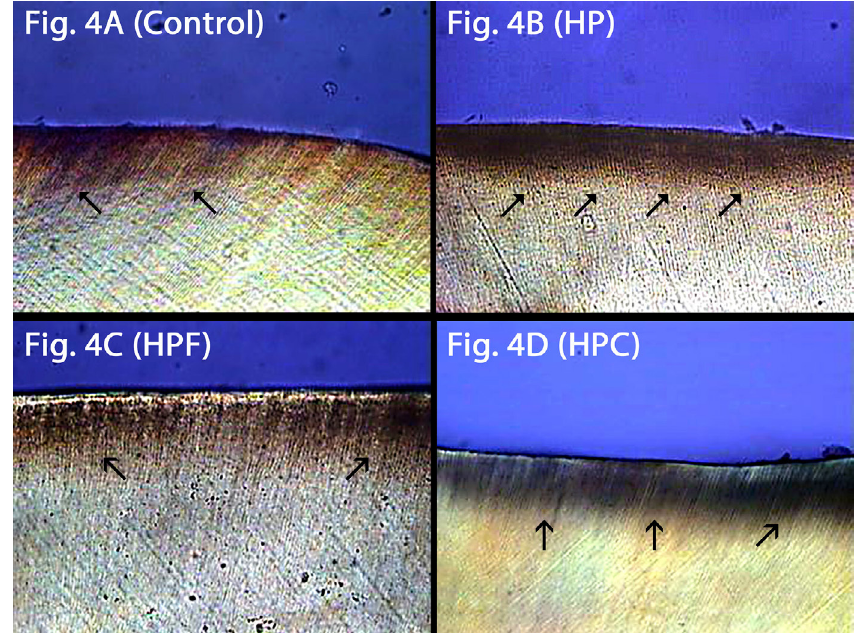
Figure 4- Demineralized enamel through polarized light microscopy. 4A: Control group with signs of surface demineralization due to the previous pH-cycling; 4B (HP): Extensive demineralized enamel subsurface area promoted by pH-cycling and bleaching treatment; 4C (HPF): subsurface demineralization similar to Figure 4D (HPC). (black arrows: demineralized